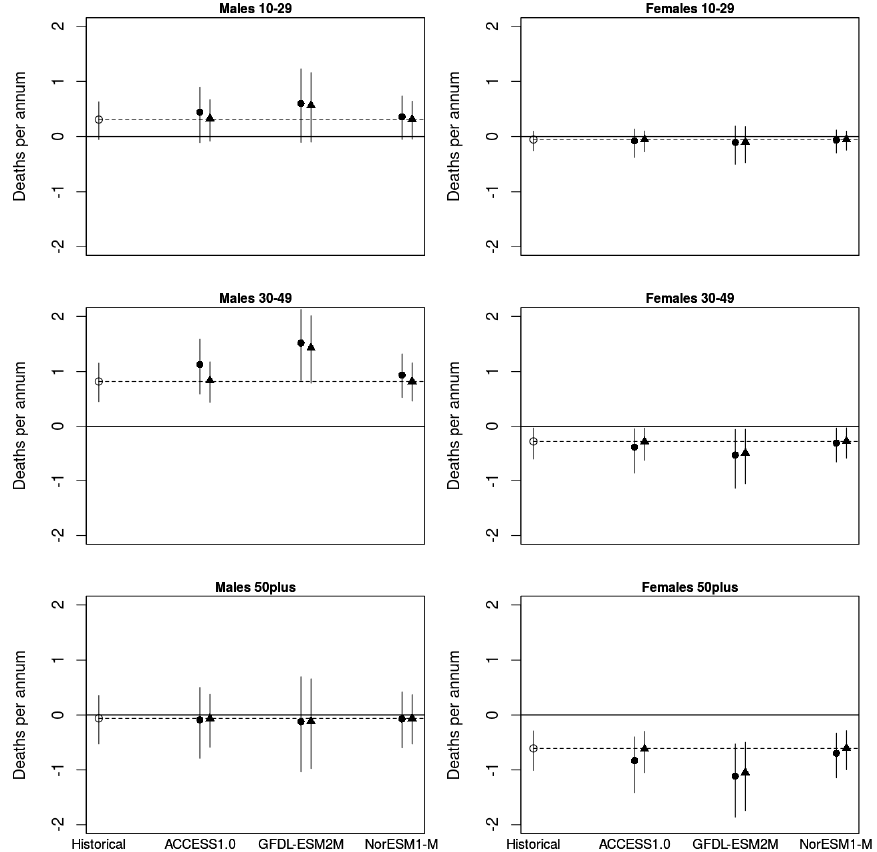
Figure 3. Numbers of suicide deaths per annum (and 95% CI) attributable to full drought conditions for each future GCM scenario (2000–2099) compared to historical rates (1971–1999); the right-hand triangular dots in each pair are RCP8.5 (high emissions scenario), while the left circular dots are RCP4.5 (lower emissions scenario).